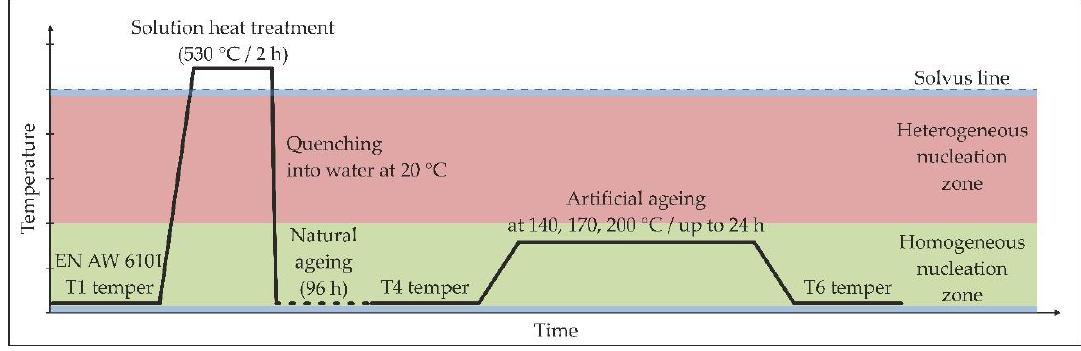
Figure 2. Temperature-time scheme of the conventional heat treatment procedure to the T6 temper.